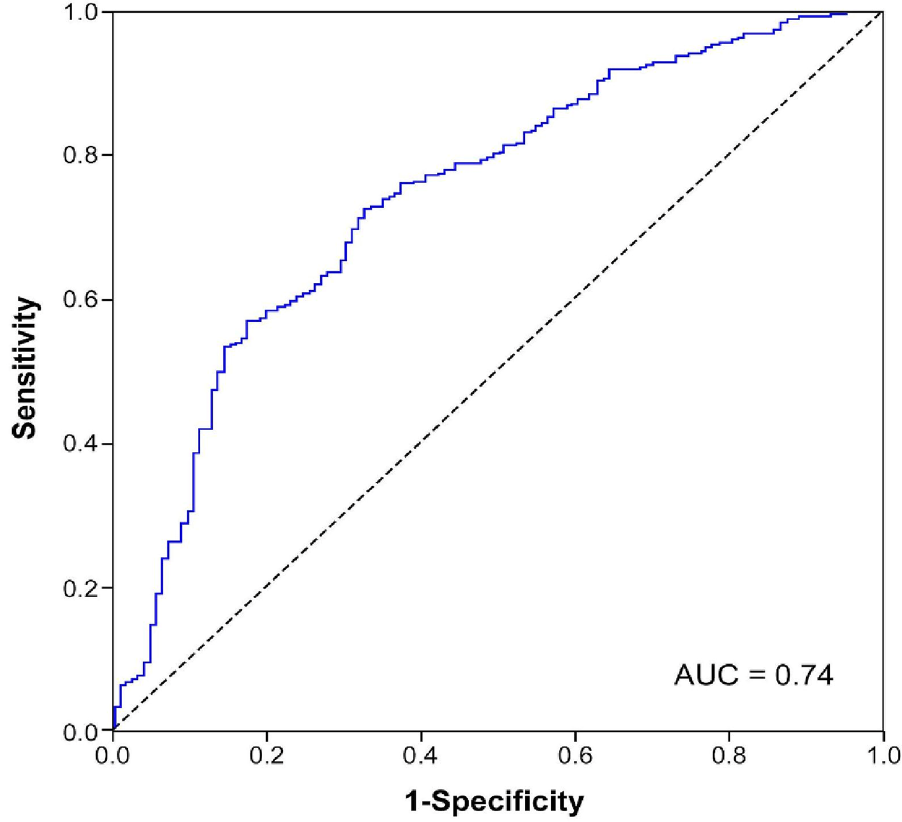
Figure 2. Receiver operating characteristic (ROC) curve of the Ankle-brachial index (ABI) for the prediction of postoperative delirium (POD) in PAD patients underwent peripheral arterial bypass surgery. Sensitivity (91.9%) and specificity (73.6%) at a cutoff of 0.35. Area under the curve (AUC) is